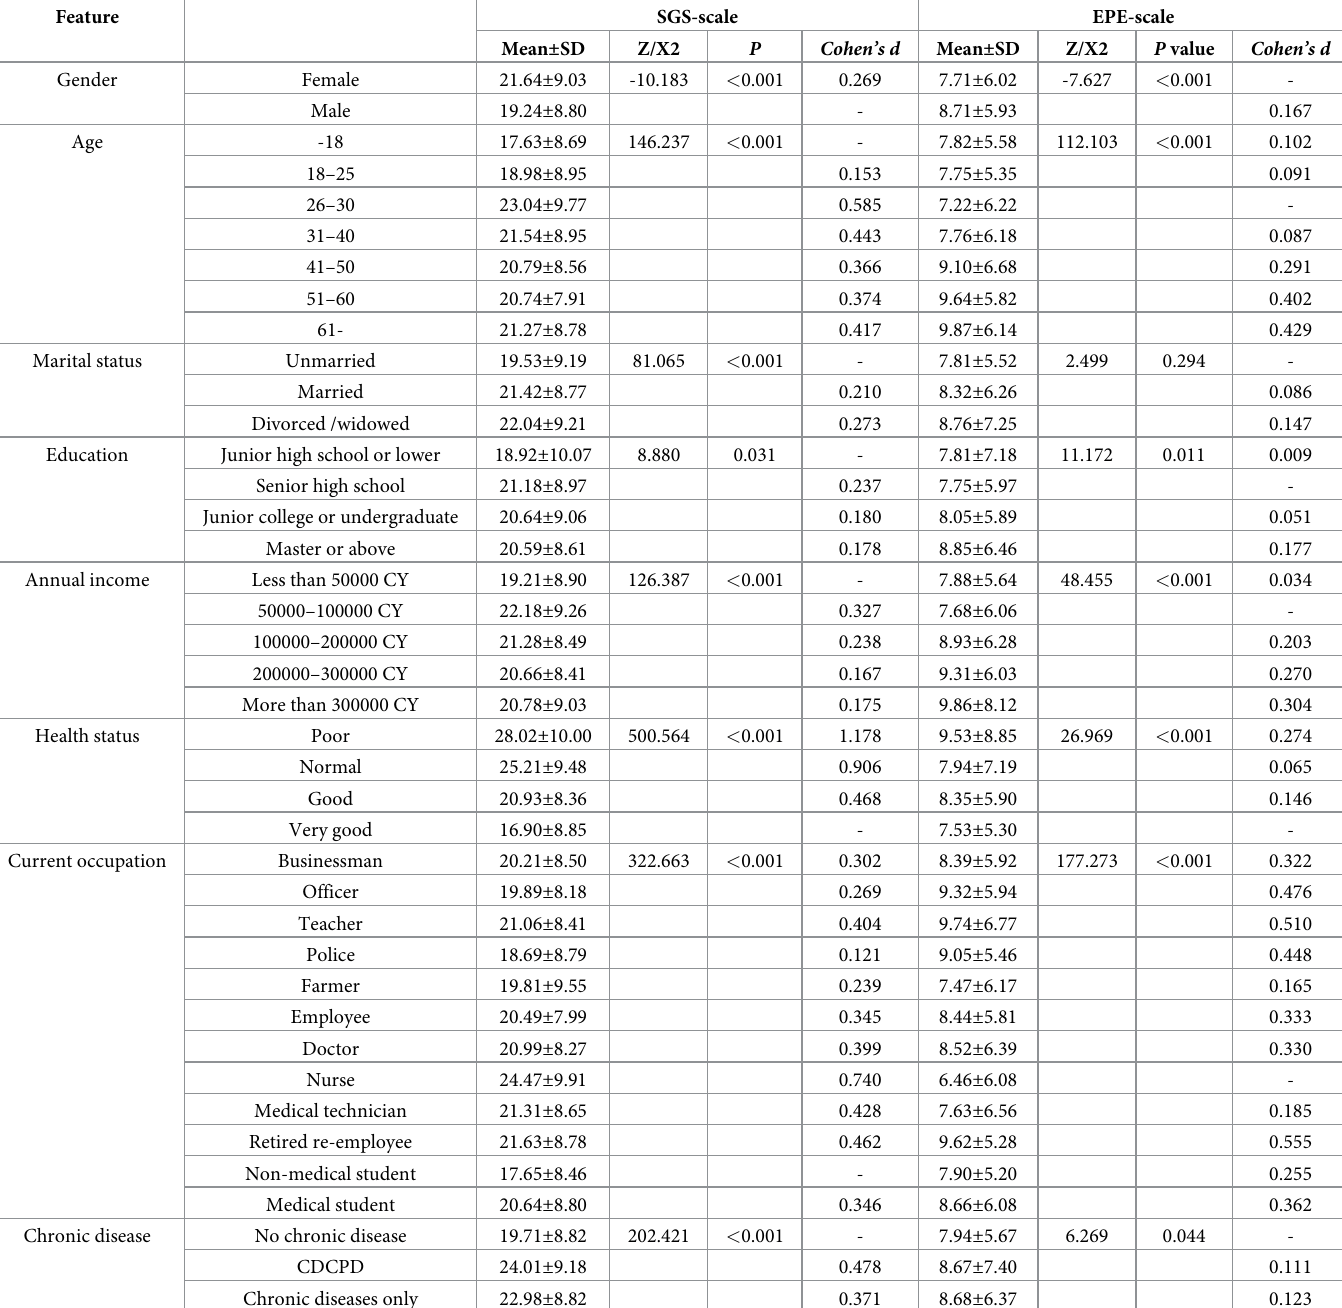
Table 2. Scores of social rhythms in participants with different sociodemographic backgrounds during the COVID-19 pandemic (N = 5854).